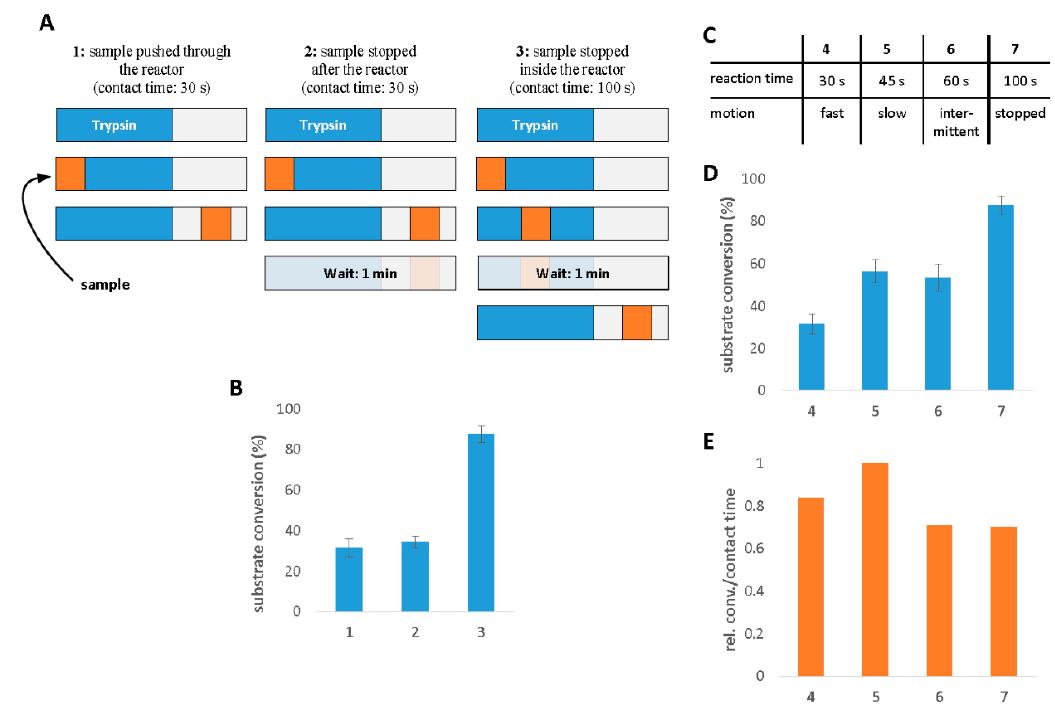
Figure 1. Experiments to verify the immobilization of trypsin: ( A ) illustrations and descriptions of the experiments 1–3; ( B ) the effect of sample movement (1–3) on the enzyme reaction; ( C ) descriptions of the sample movement conditions 4–7; the effect of sample movement (4–7) on the enzyme reaction ( D ). Substrate conversions divided by the contact time and normalized to 1 for sample movements 4–7 ( E ). Measurement parameters: fused silica capillary, ID = 50 µ m, 34 cm length (Leff = 26 cm); BGE: 25 mM NH 4 Ac pH = 7; trypsin solution: 20 mg/mL; substrate: 1 mM N α -Benzoyl-L-arginine ethyl ester; voltage: 25 kV; UV detection: 230 nm; sample injection: 50 mbar · 2 s. Preconditioning and injection parameters are detailed in Table S1 and Table S2, respectively.